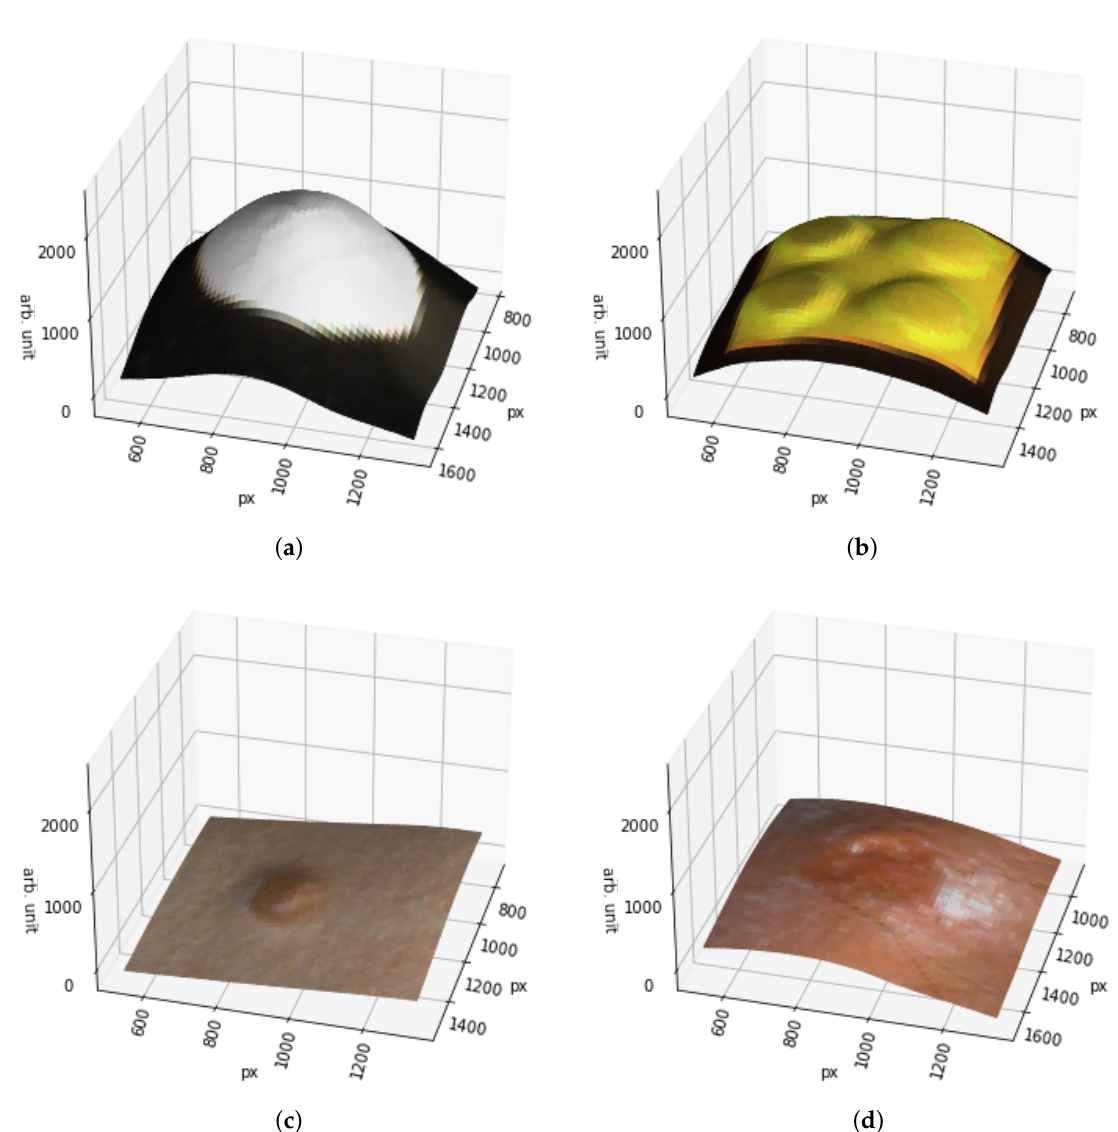
Figure 14. Surface models of ( a ) Small styrofoam ball, ( b ) Two times two yellow Lego-brick, ( c ) Intra- dermal nevus on human skin and ( d ) Human skin with nodular basal cell carcinoma. An example of albedo spectra with their deviation can be seen in Figure